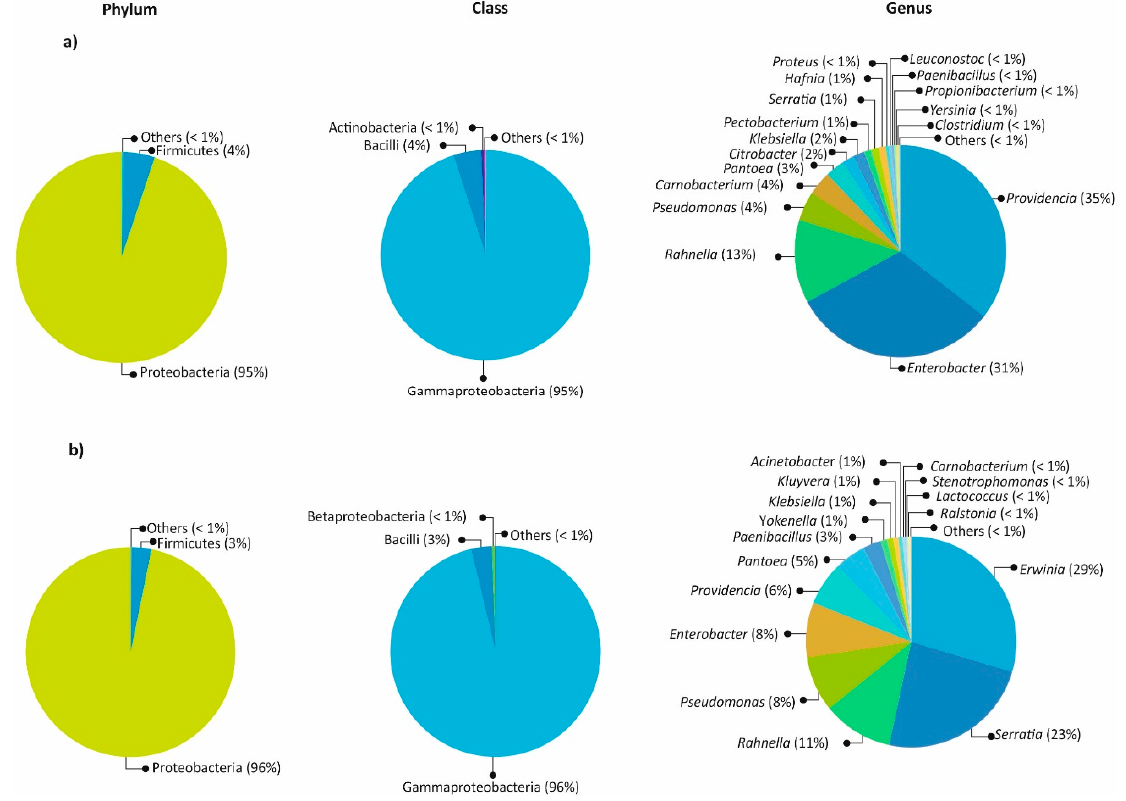
Figure 2. Relative abundances of the most abundant taxa of the gut at phylum, class, family, and genus levels: ( a ) Dendroctonus valens , ( b ) D. mexicanus .